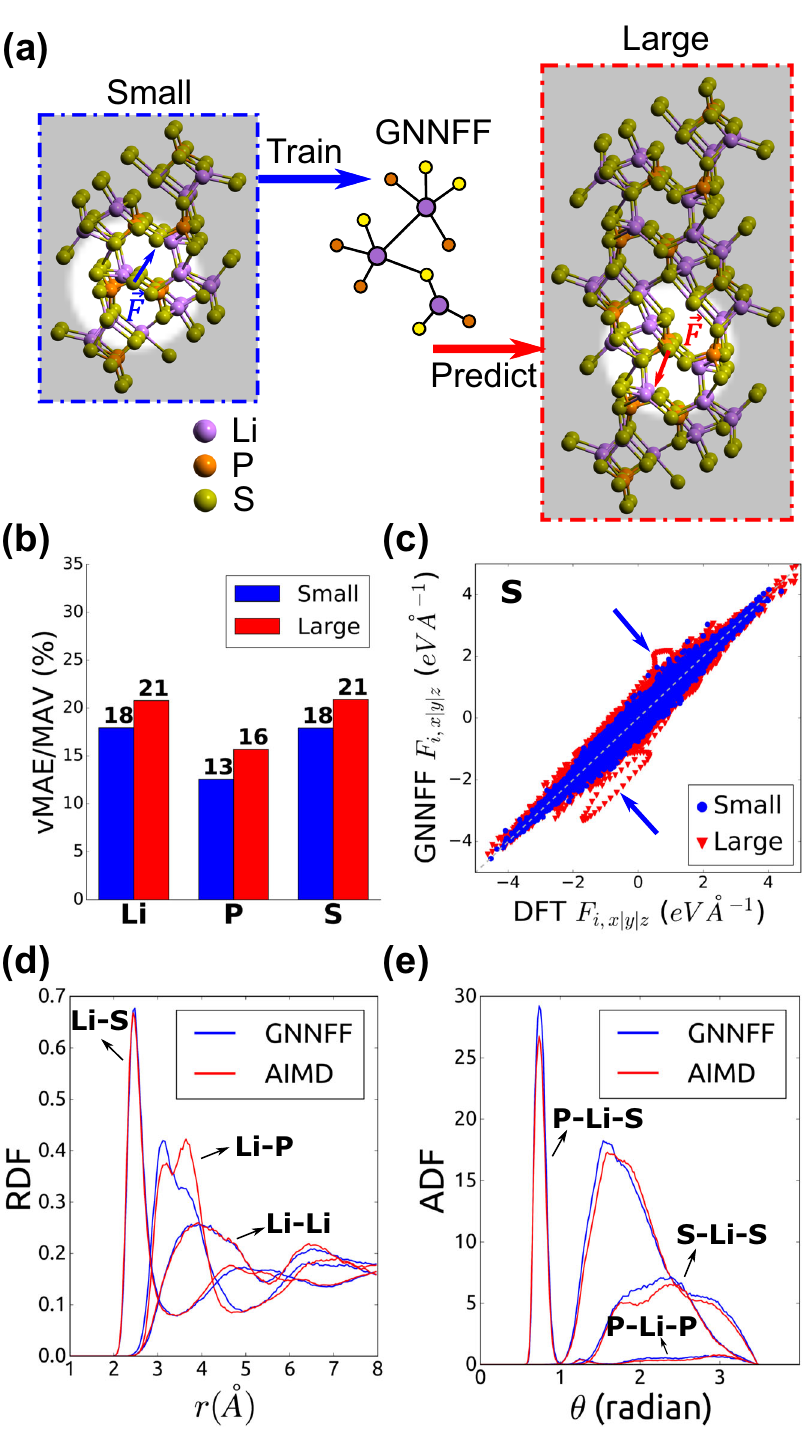
Fig. 4 Evaluating GNNFF scalability on AIMD trajectories of Li 7-x P 3 S 11 with differing x values. a GNNFF is trained on “ Small ” trajectory ( x = 0.25) forces and tested on “ Large ” trajectory ( x = 0.125) forces b Comparison of GNNFF performance when evaluated on “ Small ” trajectory forces not used for training vs “ Large ” trajectory forces. c GNNFF-predicted vs DFT-calculated force correlation plots of S for both “ Small ’ and “ Large ” systems. Blue arrows indicate signi fi cant deviations of ML-predicted values from DFT-calculated values. Comparison of the d radial distribution functions of different element pairs involving Li and e angular distribution functions of different element triplets involving Li from GNNFF and AIMD generated “ Large ” trajectories. The second element is the central atom of the